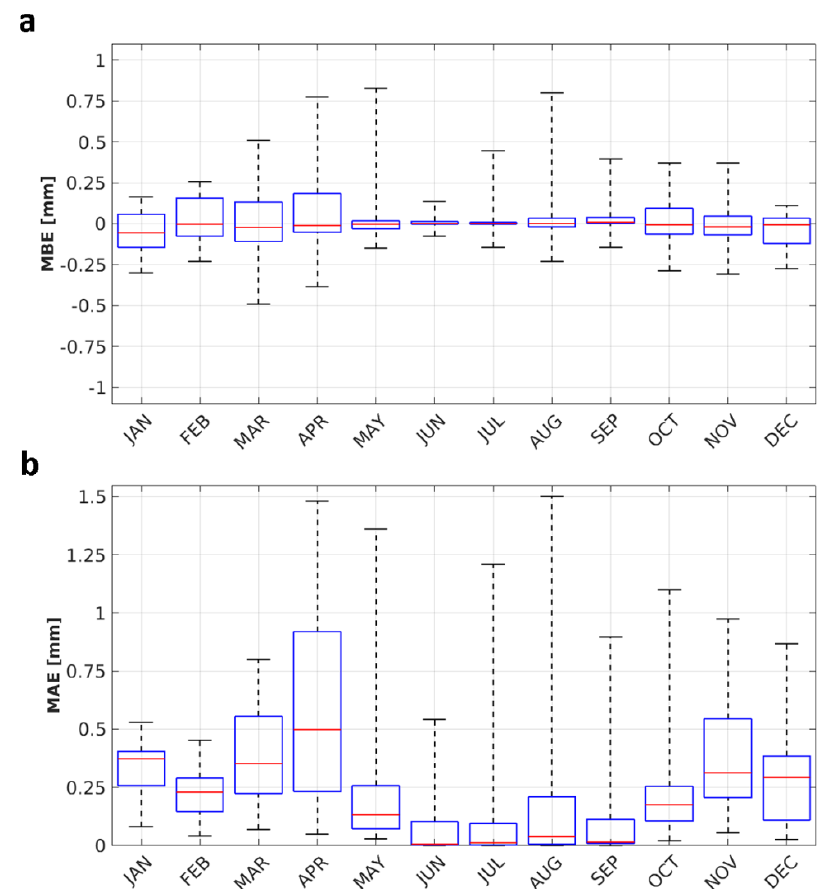
Figure 6. Inter-annual ( a ) MBE and ( b ) MAE variation between modeled and station precipitation data. Central red marks display the median, box edges display the range between the 25th and 75th percentiles and the whiskers point to the minimum and the maximum values, respectively.